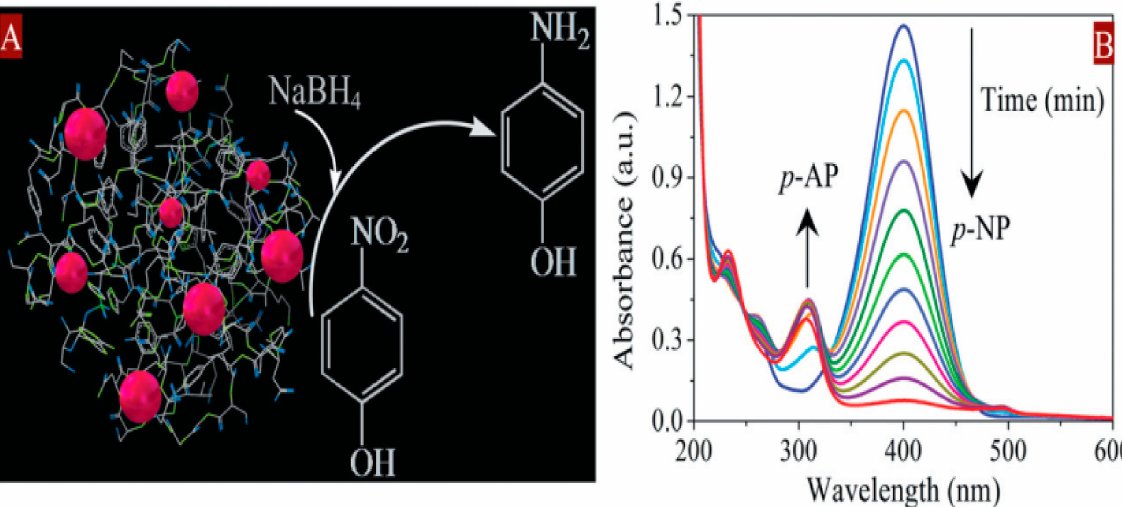
Figure 54. Catalytic activity of AuNBC ( A ) for p-NP reduction. Time dependent UV-vis absorption spectra ( B ) for catalytic reduction of p-NP by NaBH4 in presence of AuNBCs. Condition used throughout: [p-NP] = 1.0 × 10 − 4 M; [NaBH4] = 1.0 × 10 − 2 M; [AuNBCs] = 0.0101 mM, T = 20 ◦ C. Reproduced with permission from Green Chem. [447], Copyright 2012,